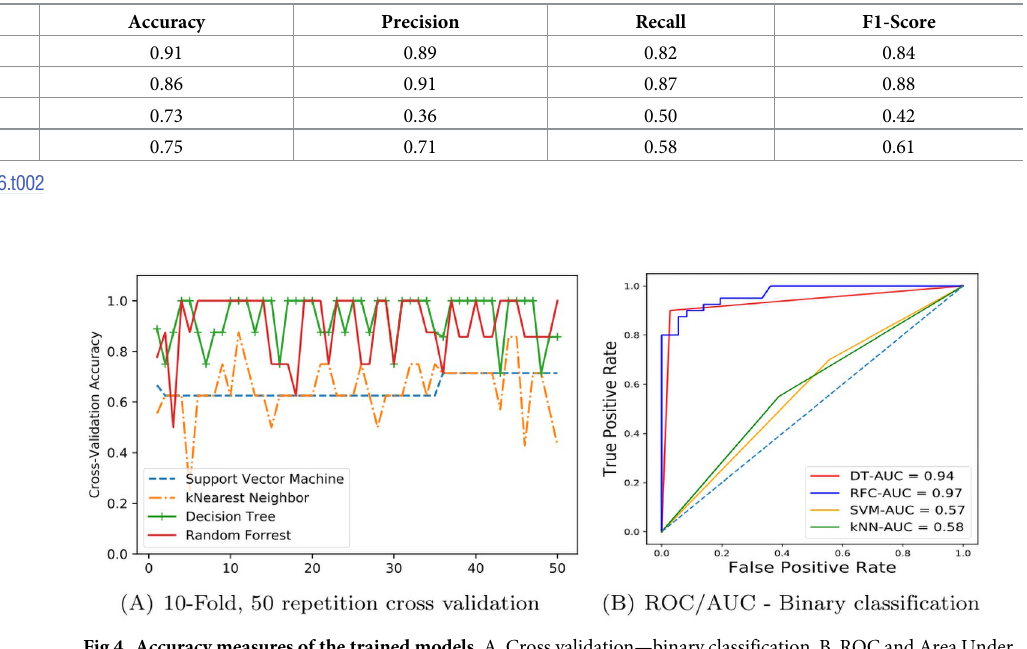
Fig 4. Accuracy measures of the trained models. A. Cross validation—binary classification, B. ROC and Area Under Curve.